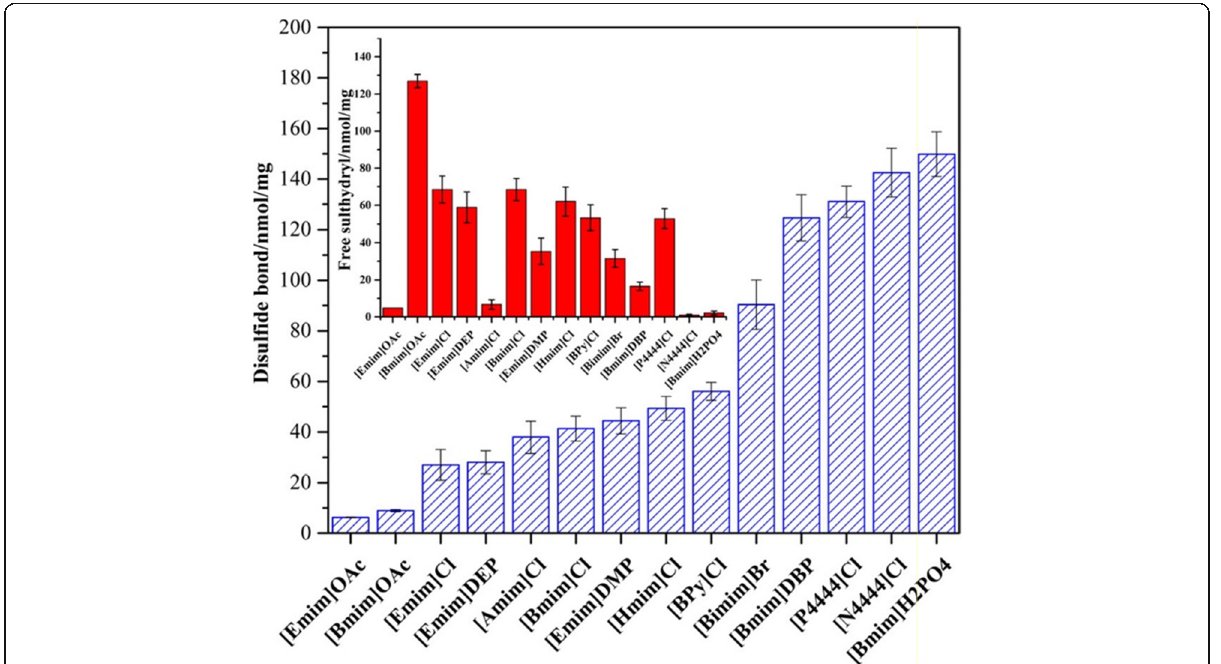
Fig. 4 Disulfide bonds and free sulfhydryl groups content of wool keratin regenerated from different ILs (120 °C, 30 min) [37]. Reprinted with permission from Reference [37]. Copyright 2017, American Chemical